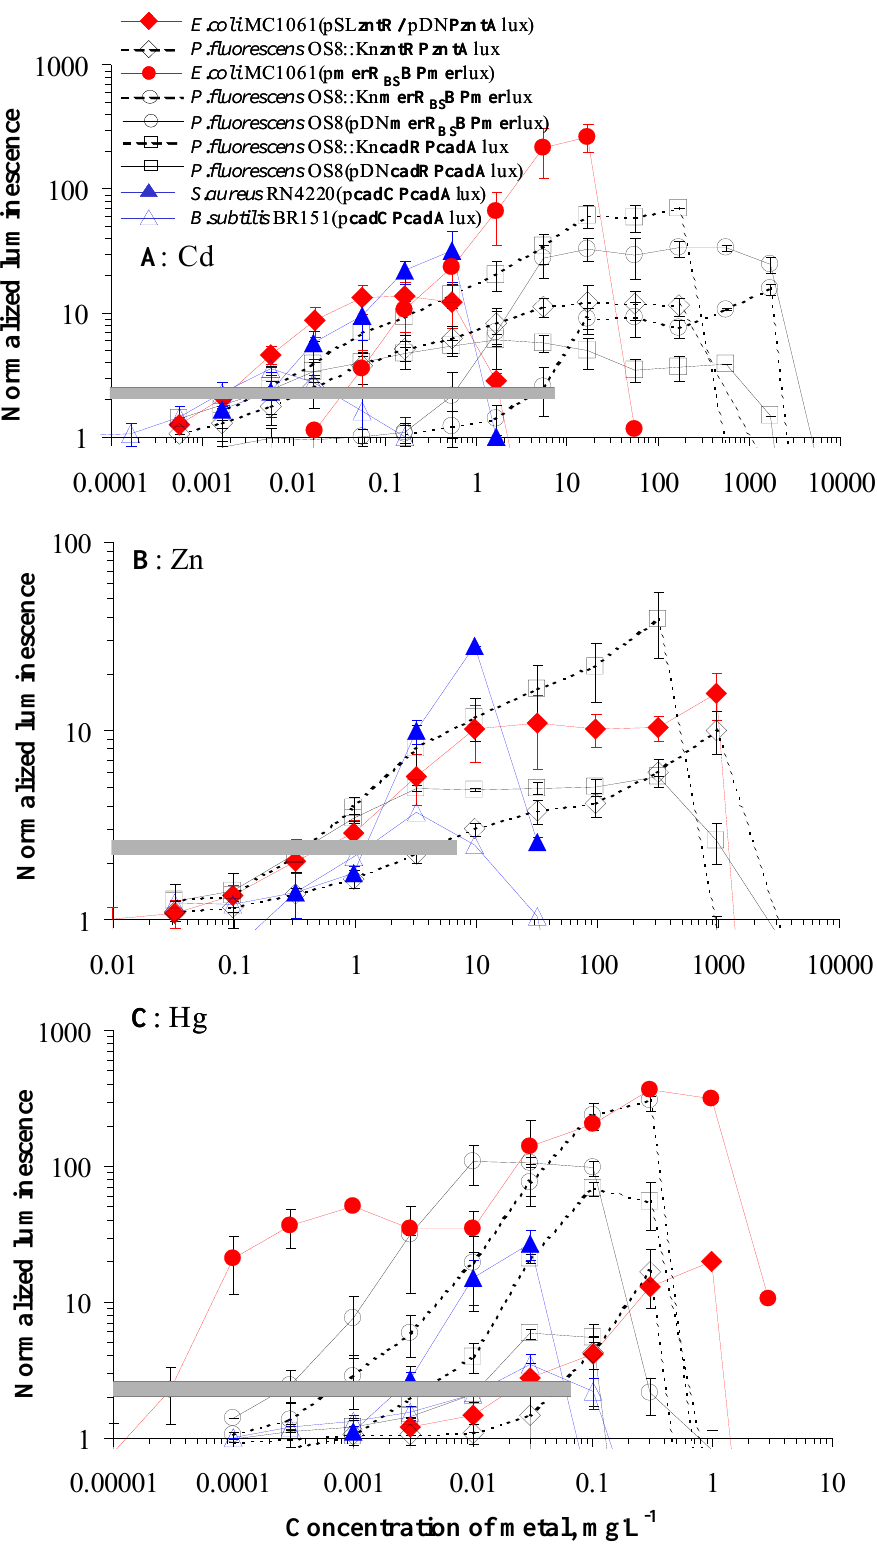
Figure 1 . Concentration-effect curves of 9 sensor strains used in this study. Induction of luminescence (expressed as normalized luminescence) in different sensor strains by Cd (A), Zn (B) and Hg (C). Data represent mean  standard deviation of at least three independent experiments. (for different sensors 2 – 4500 µg ·L -1 of Dashed horizontal grey areas indicate the range of NL LOD Cd , 400 – 5000 µg ·L -1 of Zn and 0.03 – 60 µg ·L -1 of Hg)